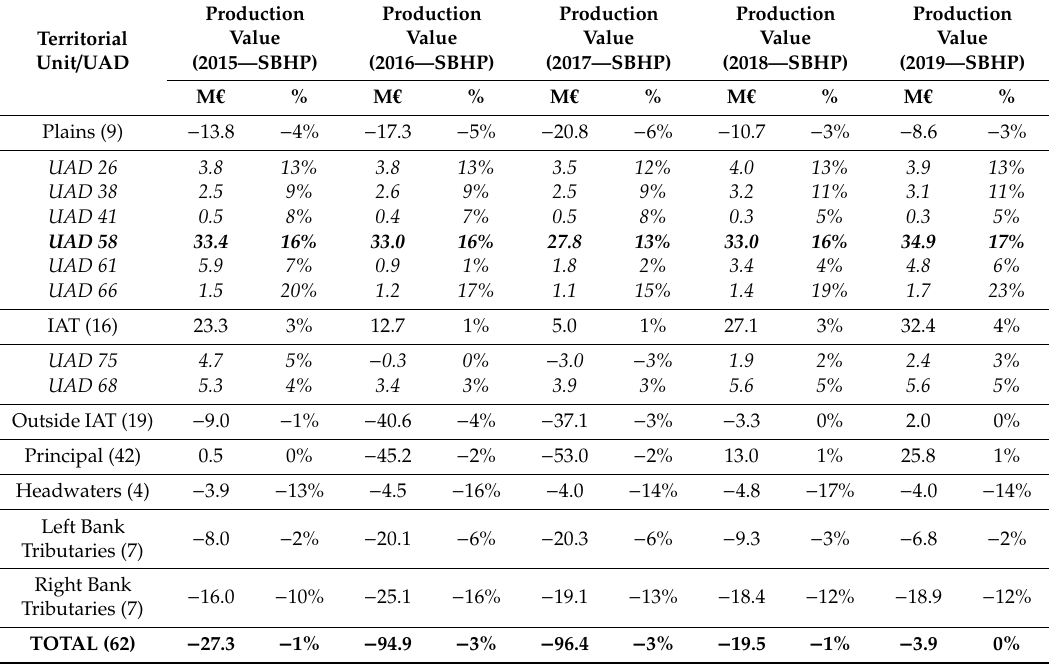
Table 13. Variation in the production value in the years analysed with respect to the value obtained with the average water applied in the SBHP, examples of some UADs with an increase in the period analysed. Source: SBHP. Own